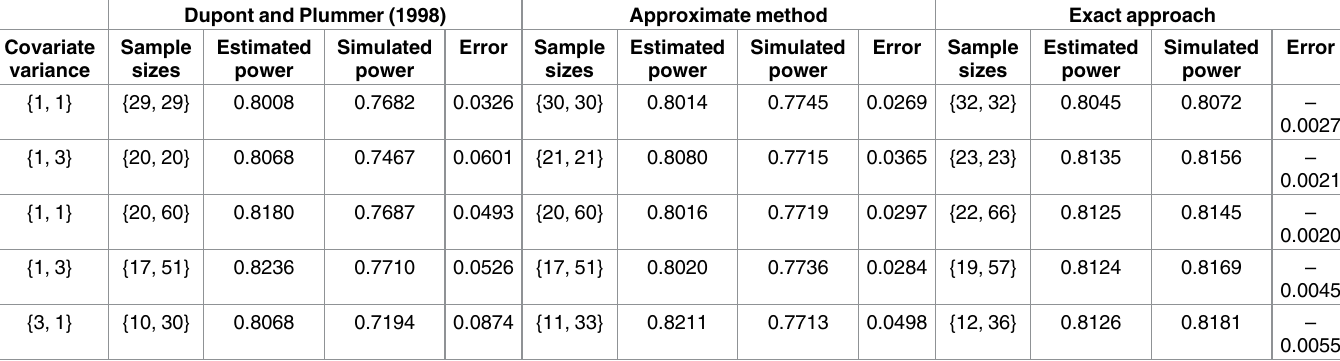
Table 2. Computed sample size, estimated power, and simulated power when δ = 0.75, Type I error α = 0.05, and nominal power 1 – β = 0.80. Dupont and Plummer